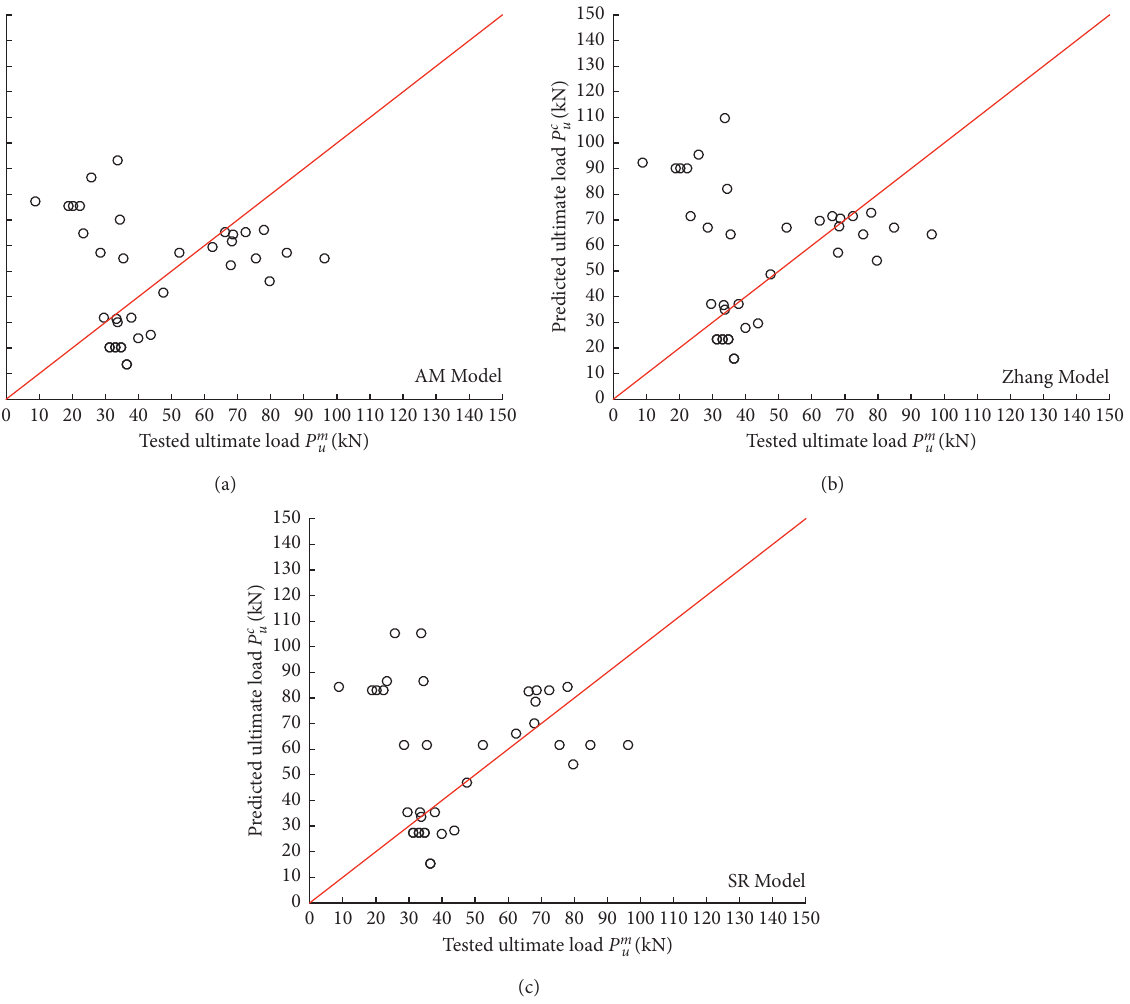
Figure 4: Comparison between the calculated value and the experimental value for the three models under concrete crush or FRP rupture failure mode: (a) AM Model, (b) Zhang Model, and (c) SR